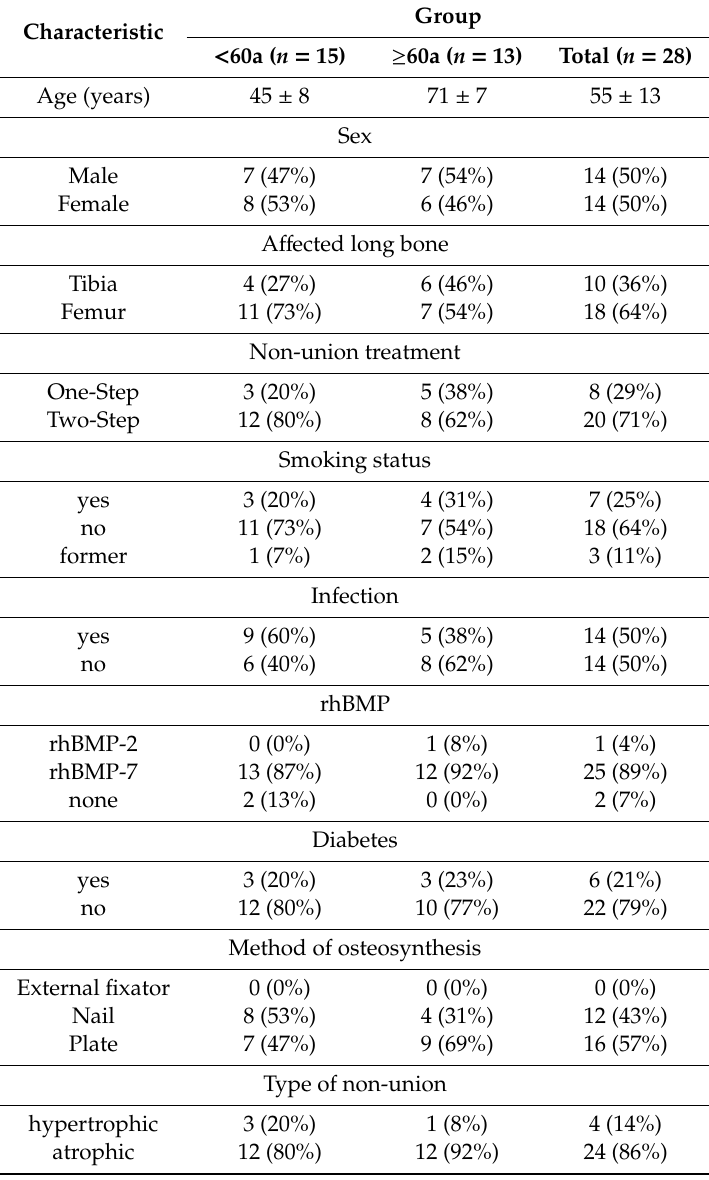
Table 2. Patient characteristics of non-responder to